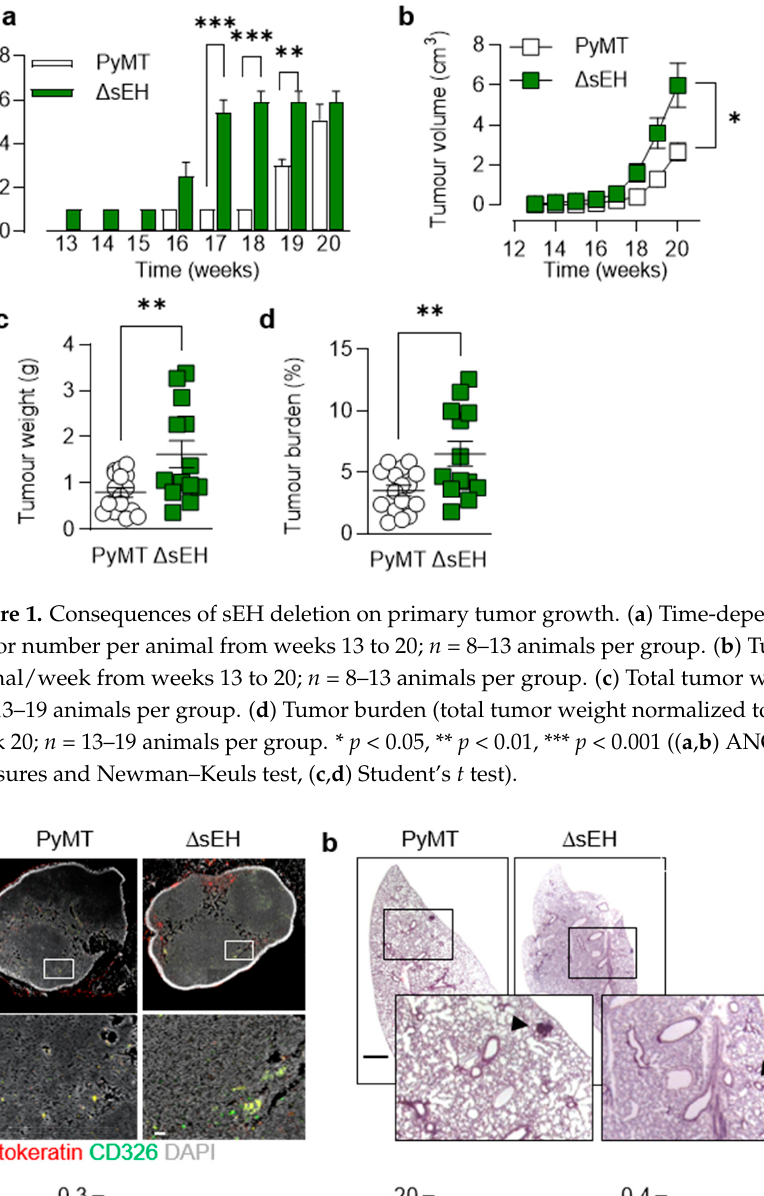
Figure 2. Lymph node and pulmonary metastases. ( a ) Metastatic tumor cells identified using cytokeratin (red) and CD326 (green) in axillary lymph nodes from PyMT and PyMT ∆ sEH ( ∆ sEH) mice, bar = 200 µ m (upper panels) 20 µ m (lower panels); n = 16–17 animals per group. ( b ) Breast cancer metastases (HE staining), metastasis number and size in lungs from PyMT and PyMT ∆ sEH ( ∆ sEH) mice; bar = 1 mm. The inserts show magnifications of the areas marked by boxes; n = 16 animals per group with 5 sequential slides evaluated per